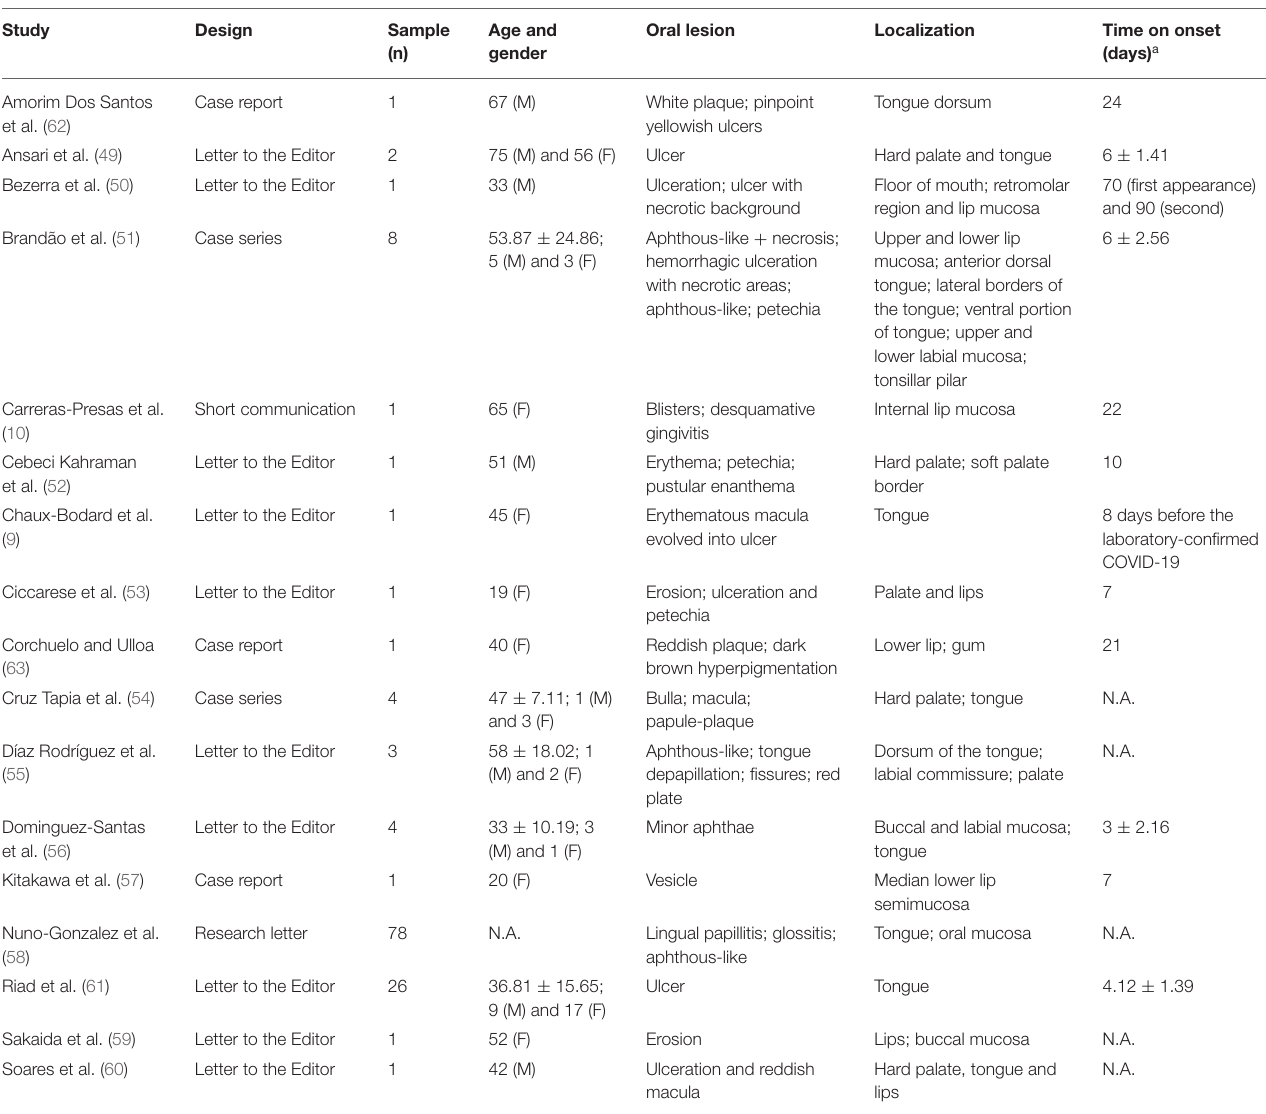
TABLE 2 | General aspects of the included